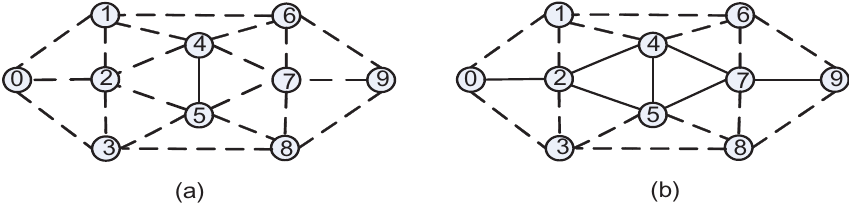
Figure 2. Vertical distance example. ( a ) Graph G . ( b ) The part with solid lines: G b